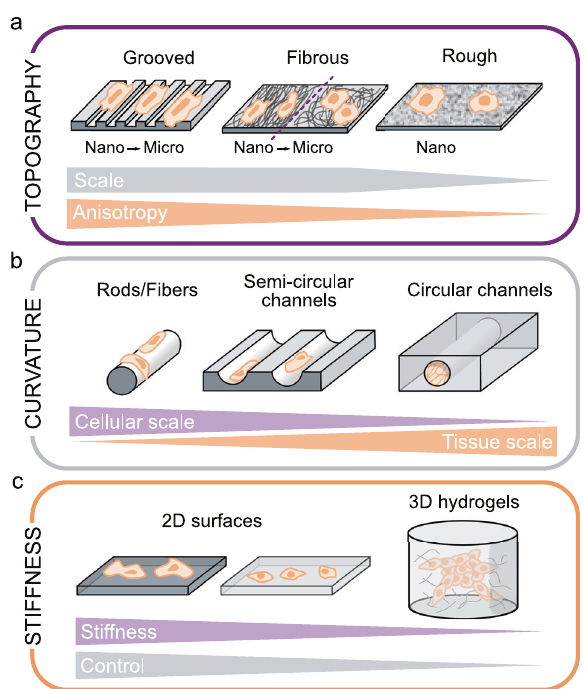
Fig. 2 Substrate-derived cues experienced by endothelial cells and associated experimental model systems. a Substrate topography can be mimicked in vitro with grooved, fi brous, or rough surfaces. Each of these systems can provide a different level of anisotropy at different scales (nano- or micro-scale). b Substrate curvature can be mimicked in vitro with microscale rods or fi bers, semicircular channels, or full circular channels. These systems provide curvature ranging from the cellular scale to the tissue (monolayer) scale. c Substrate stiffness can be tuned in either 2D surfaces (where increased cell spreading is observed on stiffer substrates) or 3D hydrogels (where smaller stiffness values can be attained but at the expense of more limited control of the extracellular